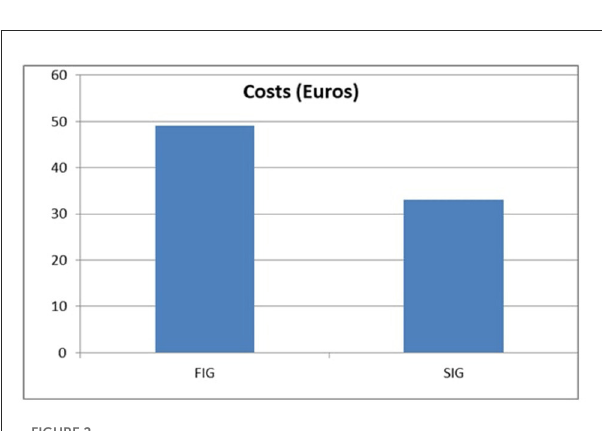
FIGURE1 Pregnancy rate for each group.